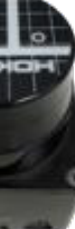
Figure 16. Laser rangefinder (Hokuyo URG-04LX-UG01).